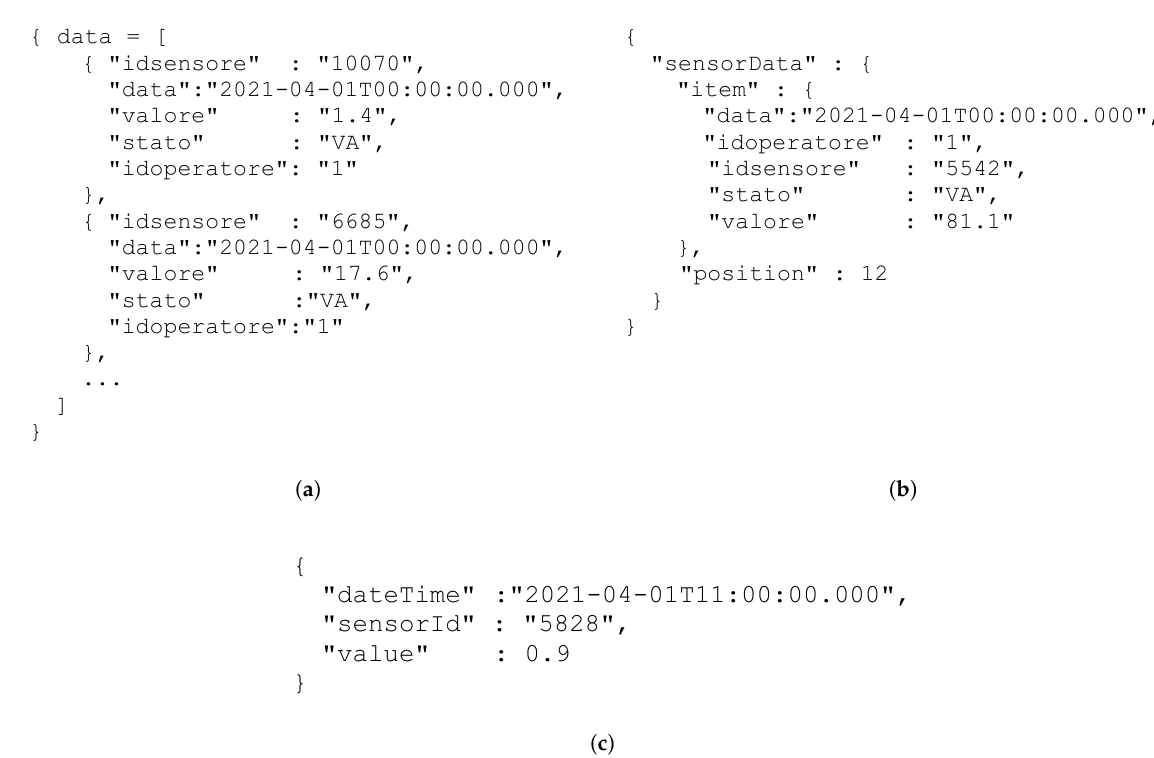
Figure 10. Examples of the temporary collections generated by line 20 ( a ), line 21 ( b ) and line 22 ( c ). ( a ) Excerpt of the beginning of the document obtained from the portal with data about air-quality measurements. ( b ) Example of a document obtained by unnesting data about air-quality measurements. ( c ) Example of a restructured document describing air-quality